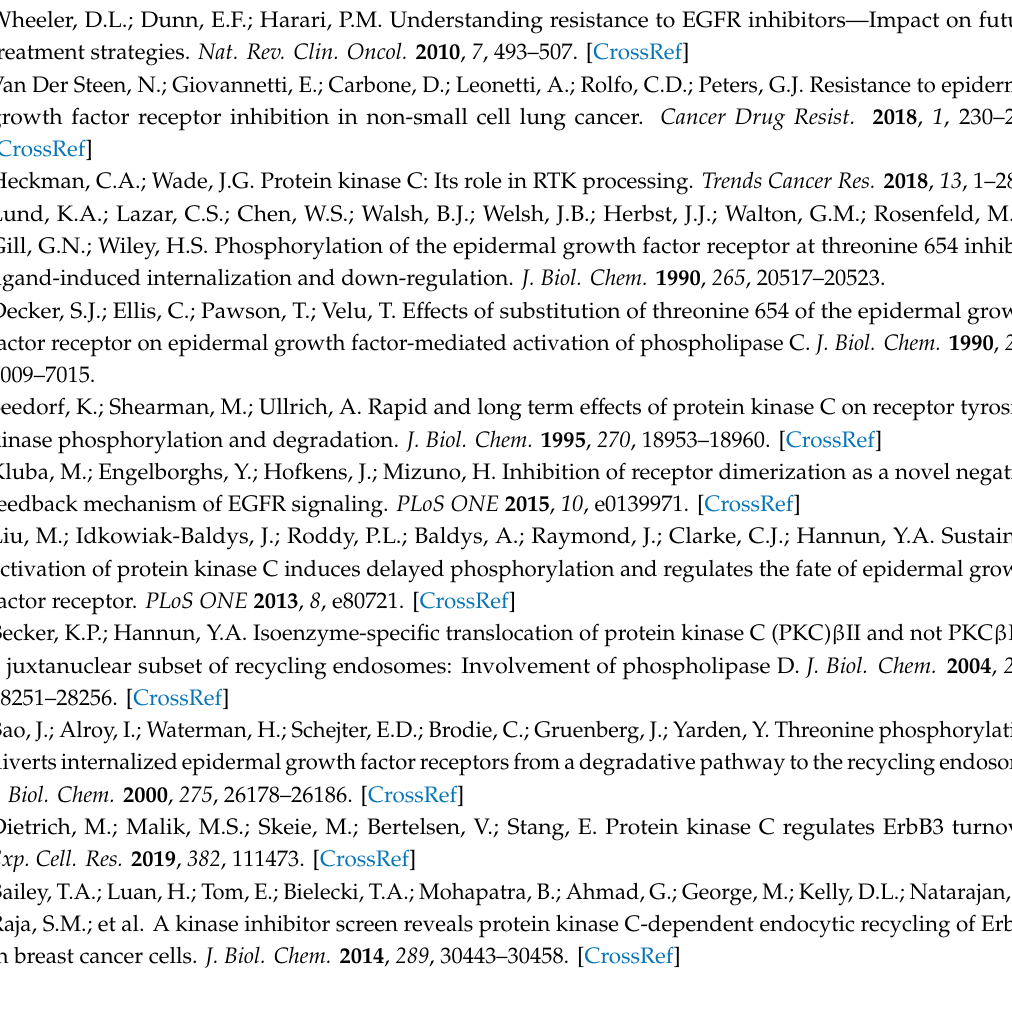
Figure S1: Characterization of anti-PKC- ε antibodies. Figure S2: PKC colocalizes with vinculin in loosely textured, actin-based features. Figure S3: Negative controls on 1000 W cells. Video S1: Stack 3F video for comparison to Figure